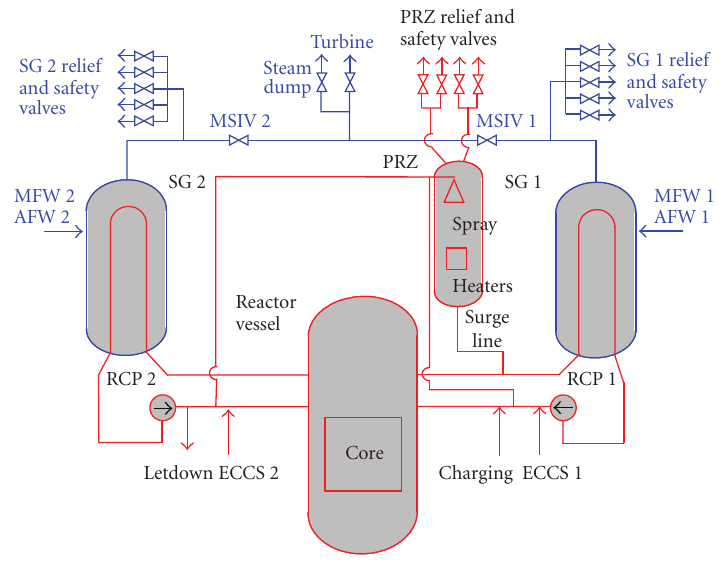
Figure 1: Krˇsko NPP simplified